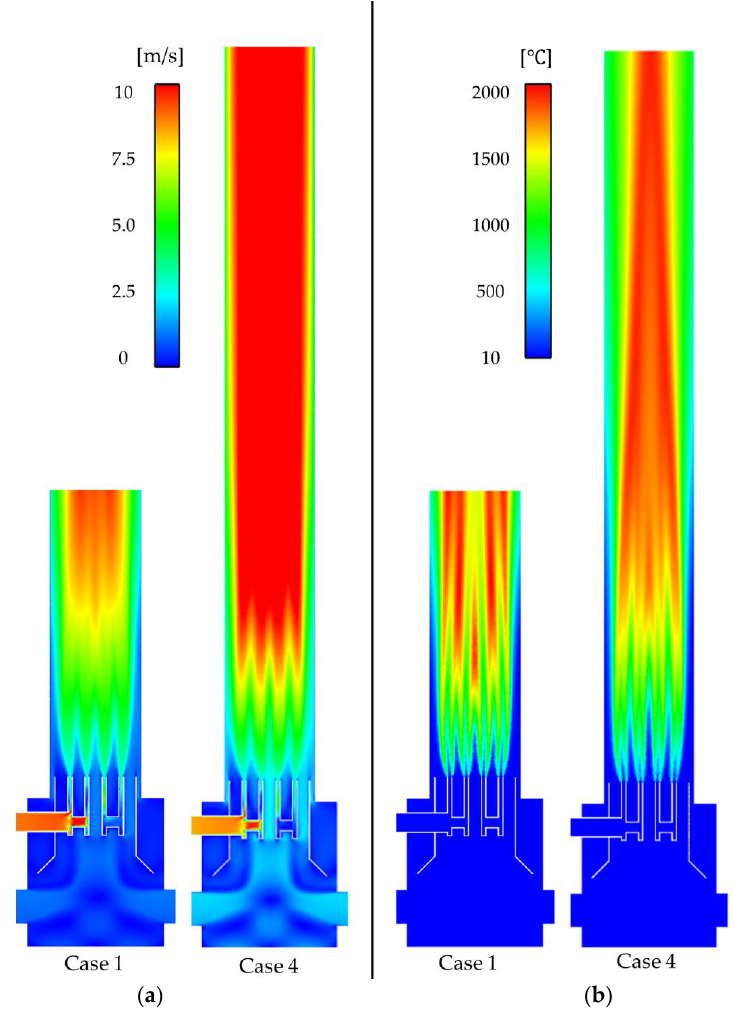
Figure 10. Comparison of the velocity and temperature distributions in the axial plane at different stack heights: ( a ) velocity, ( b ) temperature.